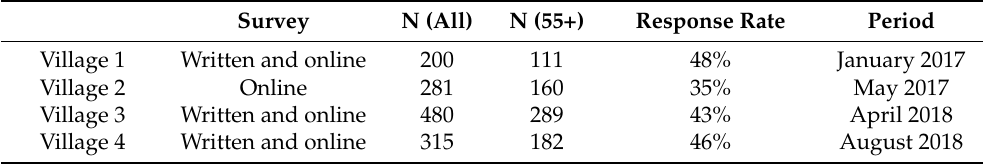
Table 2. Information about the survey research that was conducted in four Dutch KRAKE villages. Survey N (All) N (55+) Response Rate Period Village 1 Written and online 200 111 48%